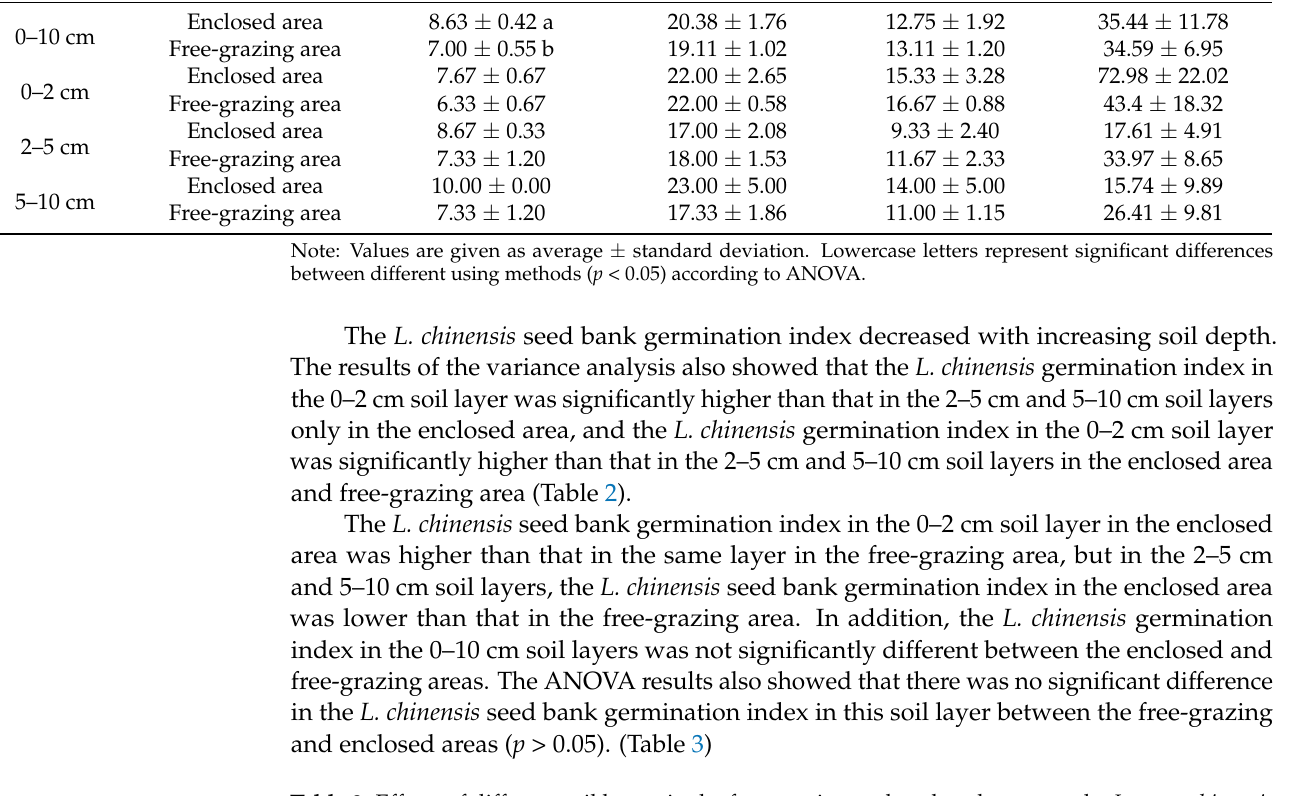
Table 3. Effects of different soil layers in the free-grazing and enclosed areas on the Leymus chinensis seed bank germination